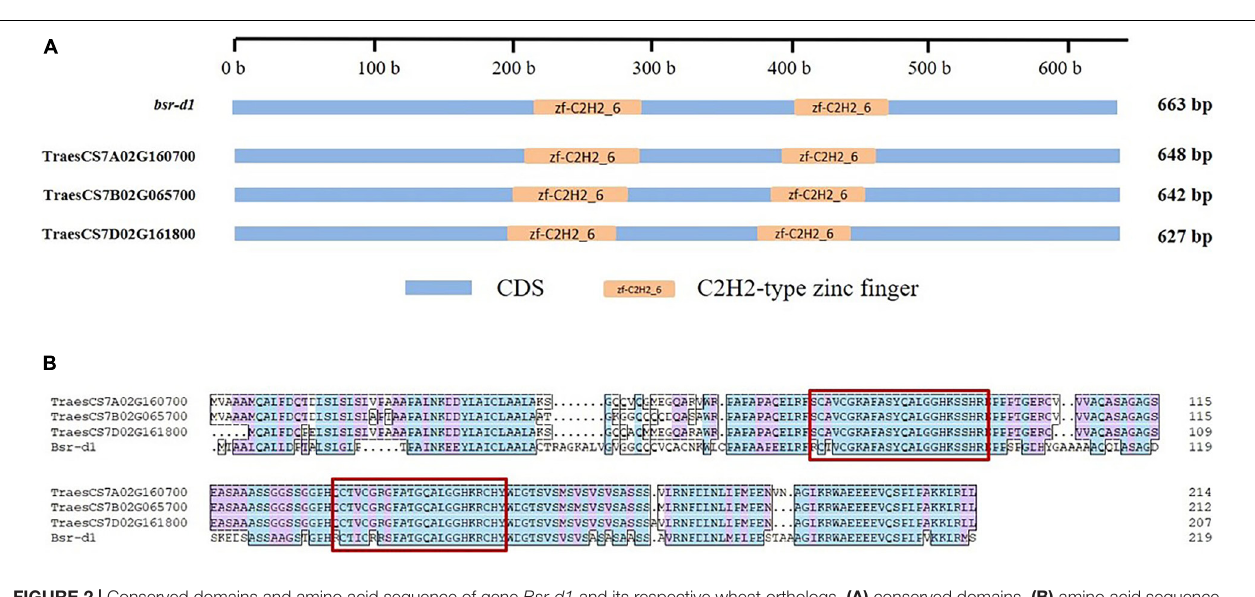
FIGURE 2 | Conserved domains and amino acid sequence of gene Bsr-d1 and its respective wheat orthologs. (A) conserved domains, (B) amino acid sequence. CDS means coding sequence, the amino acid sequence of two conserved zinc fingers are highlighted by red rectangles. TABLE 1 | Mutation densities of Bsr-k1 and Bsr-d1 wheat orthologs in the M2 population after EMS treatment. Gene NCBI accession Gene size (kb) Sequenced fragment Mutation Mutation number size (kb) number density TraesCS1A02G207700 MW388661